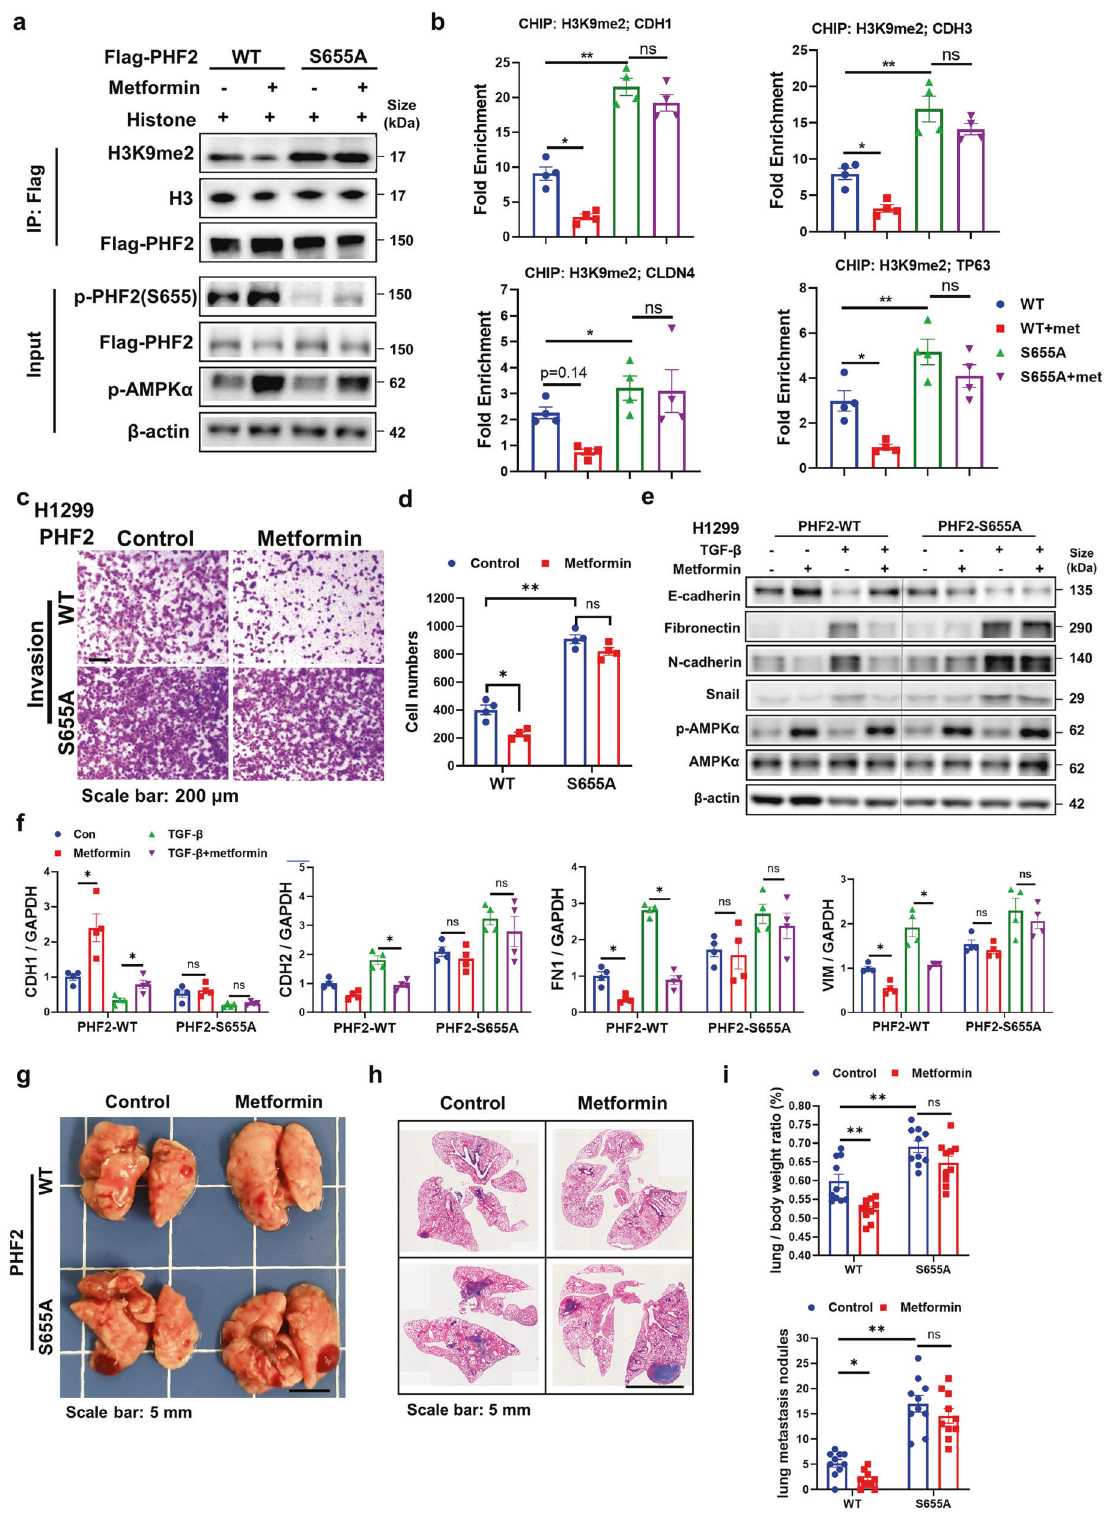
display contradictory effect on cancer metastasis, interesting us to consider that AMPK may play different roles in diverse tumor environments and an inside balance maybe presents between the two catalytic